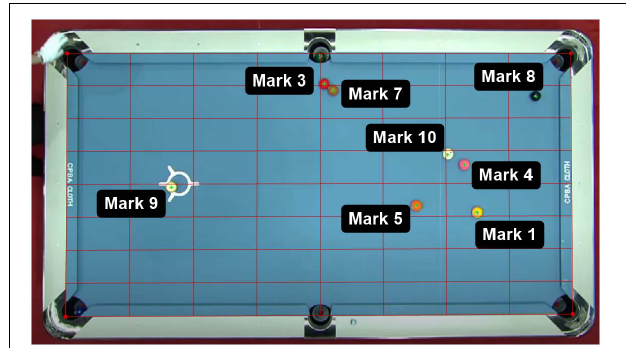
FIGURE 1 | Example of 2D video analysis in Kinovea, where a “perspective grid” (red) was applied to calibrate the pool table and the “mark” (green) was added in the center of each ball. Marks 1–9 indicates 1-ball to 9-ball; Mark 10 indicates the cue ball; 2-ball and 6-ball went into the pocket and therefore not shown. Video was extracted from publicly available source